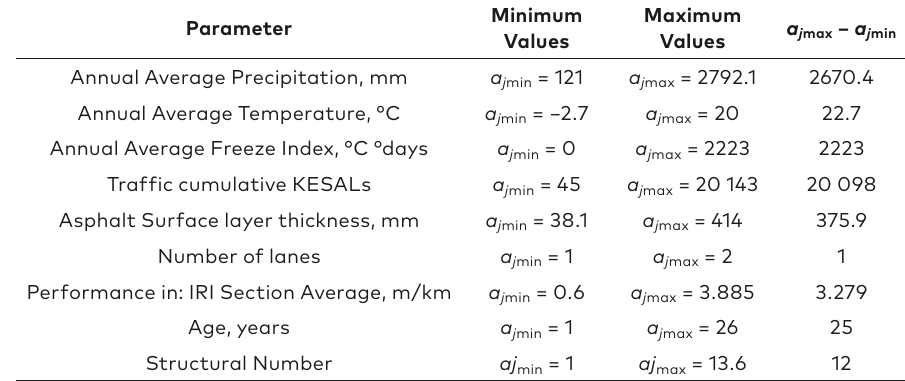
Table 8. Attribute range in the case library